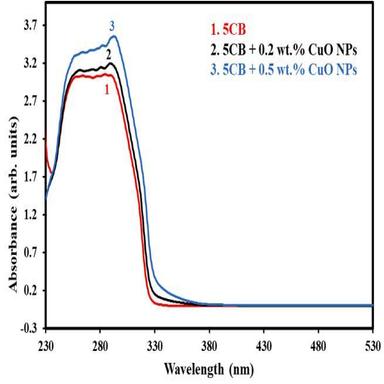
UV–Vis absorption spectra for pure 5CB and its nanocomposites.